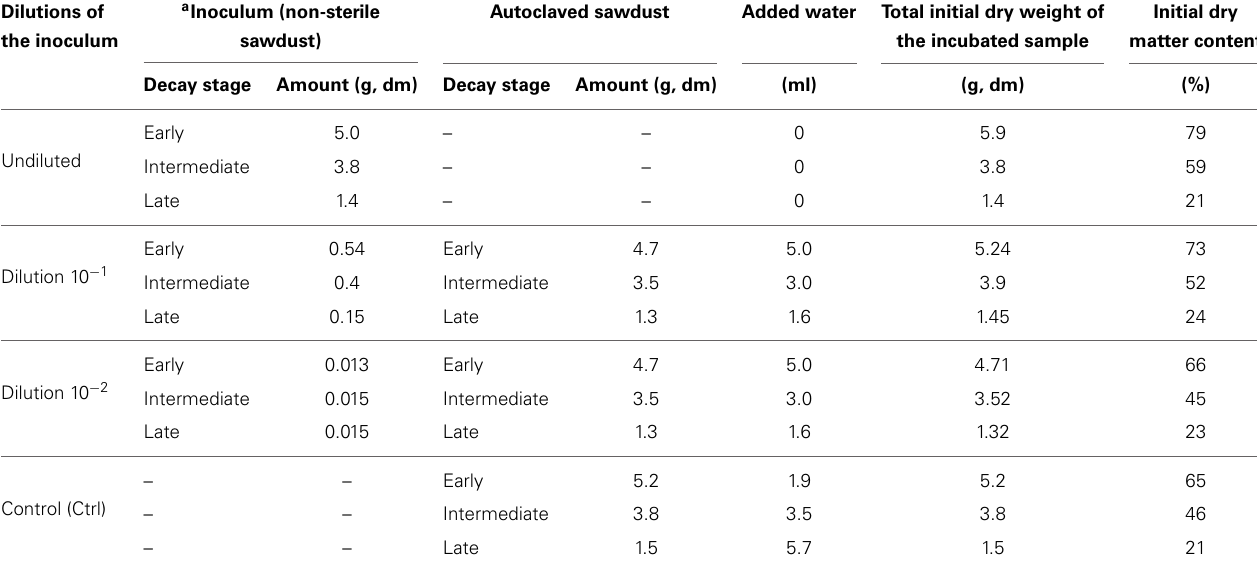
Table 2 | Amount of inoculum (non-sterile sawdust) or autoclaved sawdust in dry form added to 100-mL glass flasks to assess the effect of fungal diversity on the decomposition activities of Norway spruce sawdust in early, intermediate and late stages of